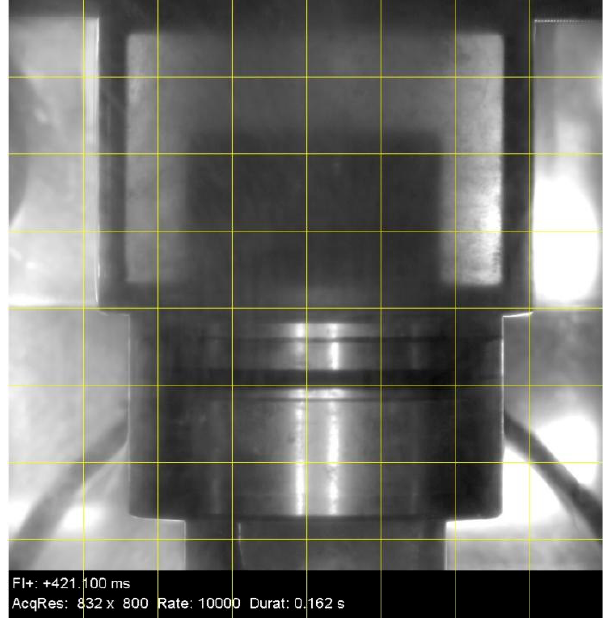
Figure 5. Grid image analysis method.